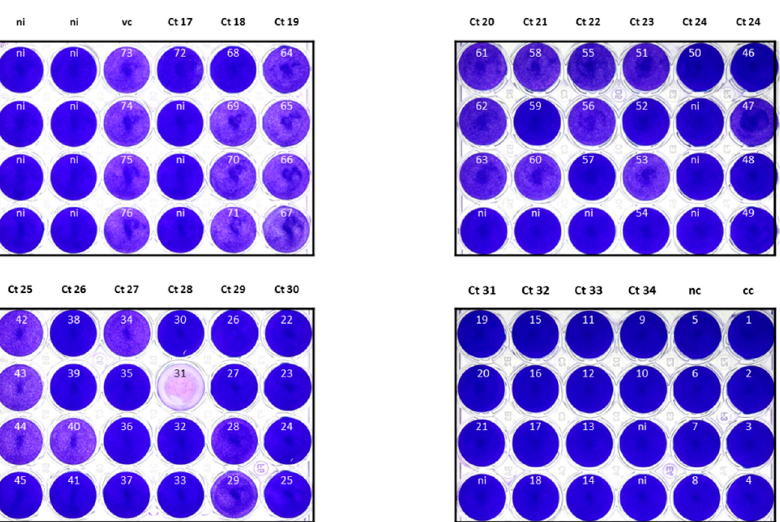
Figure 5. Cytopathic effect after two passages (third round) of 64 upper respiratory tract samples (no. 9–72) in Vero cells with respect to the threshold cycle (Ct) values of the original sample (N-gene triplex RT-PCR). For comparison, positive controls (vc, no. 73–76; own SARS-CoV-2 isolates), negative controls (nc, no. 5–8; SARS-CoV-2 free patient samples) and cell controls (cc, no. 1–4, and ni; cells in medium) are included. Note that the destroyed cell layer in no. 31 represents an artifact and does not correlate to the result of N-gene triplex RT-PCR from the supernatant (compare Figure 4).